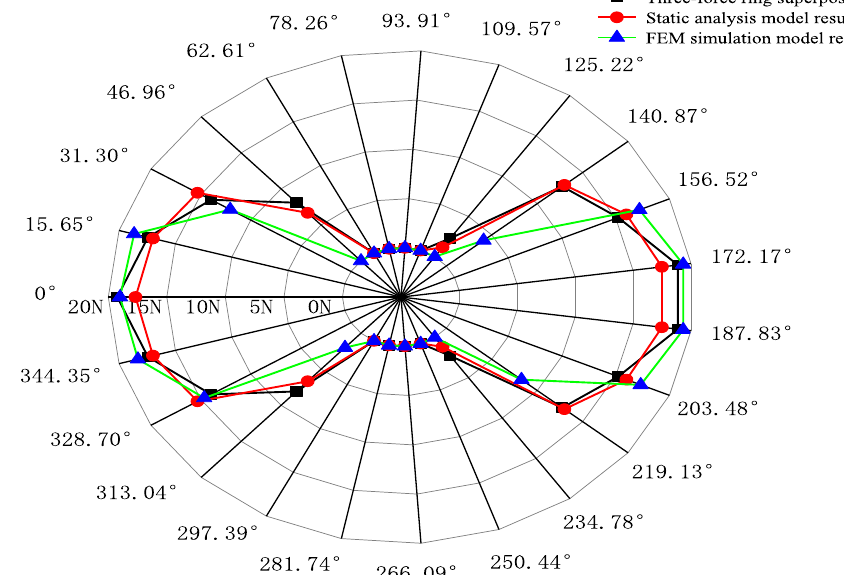
Fig. 7. The ball load distribution comparison of the FB LY-6025.